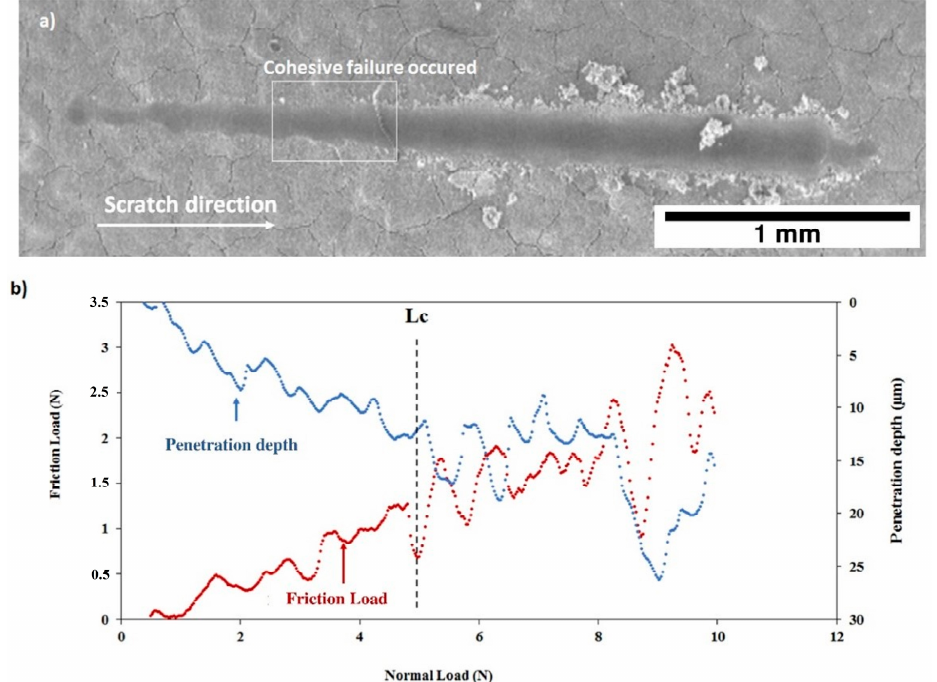
Figure 17. Scratch test of the C90 coating after thermal treatment: ( a ) SEM micrograph of the scratch and ( b ) friction force and penetration depth as a function of normal load.